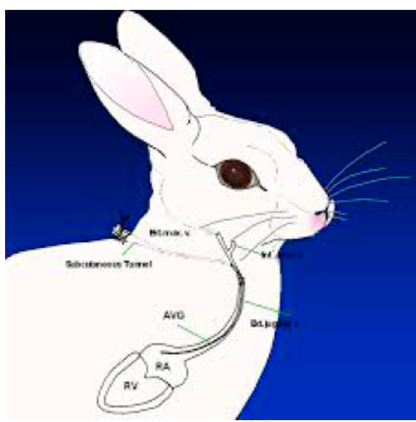
Figure 2. New Zealand white rabbit with tunneled central Silastic venous catheter. The vascular catheter is inserted into the right external jugular vein and then tunneled subcutaneously to exit in the midline anteriorly to the scapulae.